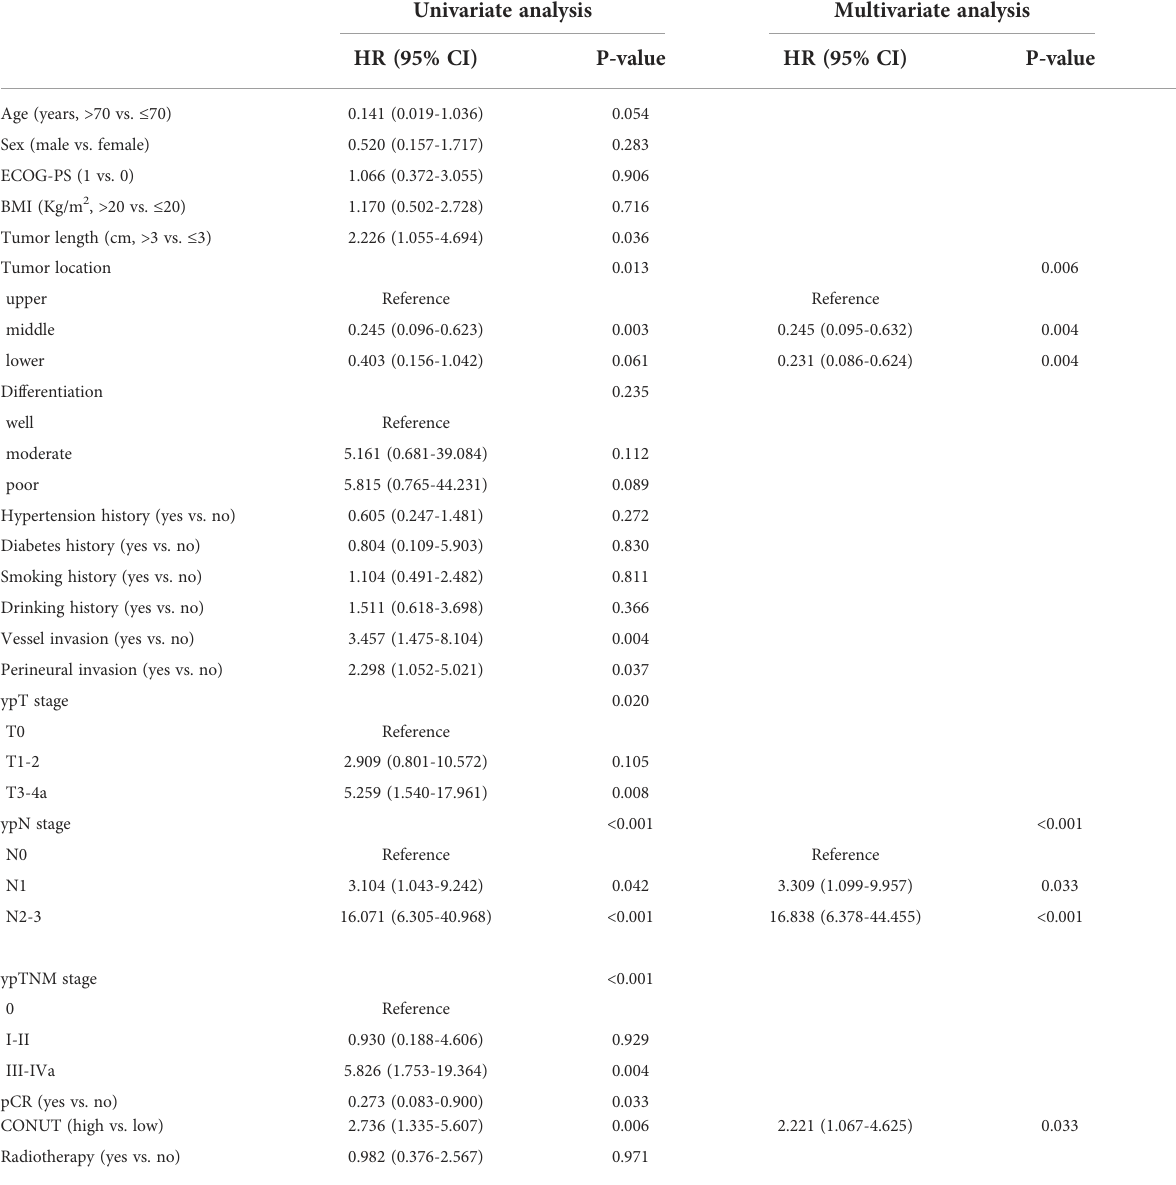
TABLE 3 Cox analyses of predictors for disease-free survival in esophageal squamous cell carcinoma. Univariate analysis Multivariate